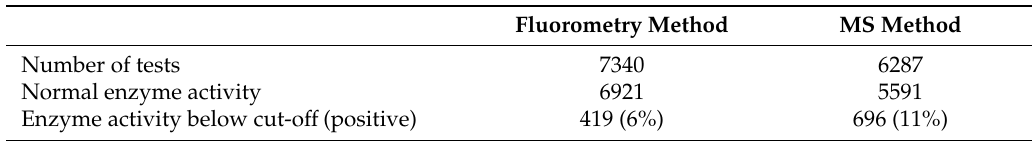
Table 1. Number of samples tested between January 2017 and December 2018 at the specialized centers in Hamburg, Germany and Vienna,